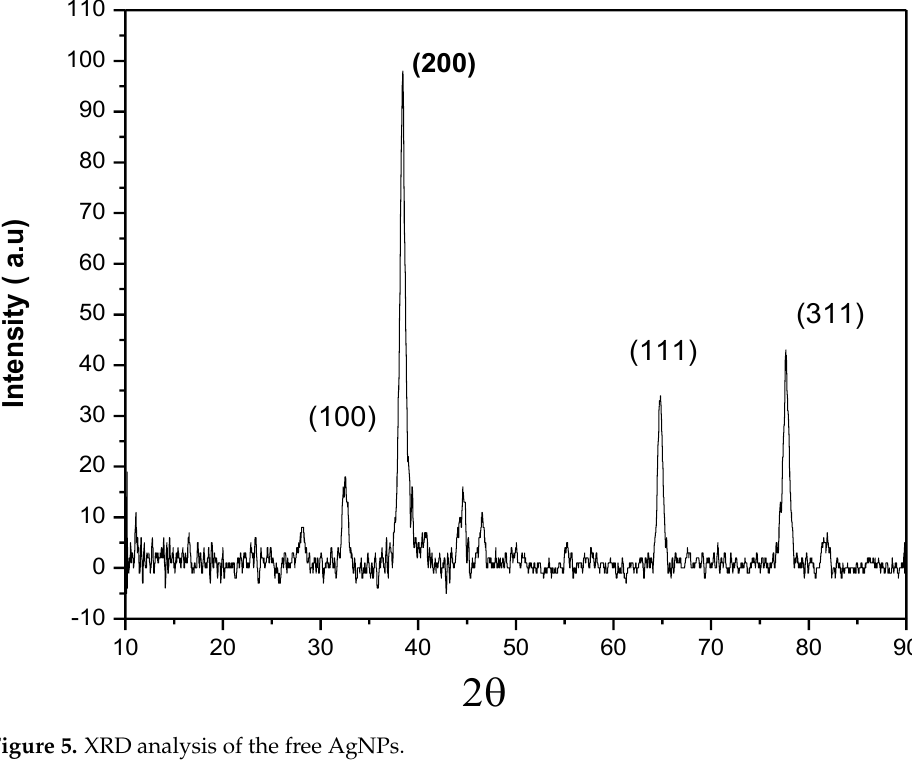
Figure 5. XRD analysis of the free AgNPs.